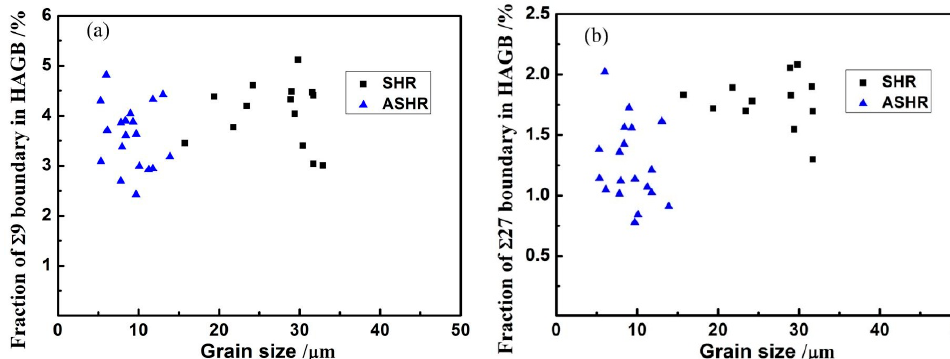
Figure 5. Fraction of Σ 9 ( a ) and Σ 27 ( b ) grain boundary in HGAB during SHR and ASHR process.